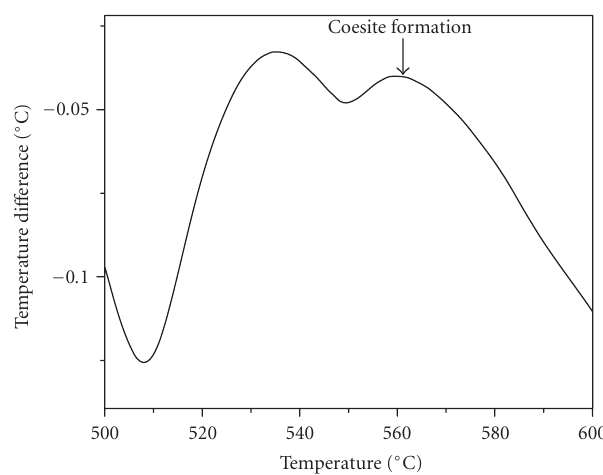
Figure 1: DTA curve of chlorophyll species embedded in a silica matrix heat-treated in nitrogen in the temperature range from 500 ◦ C to 600 ◦